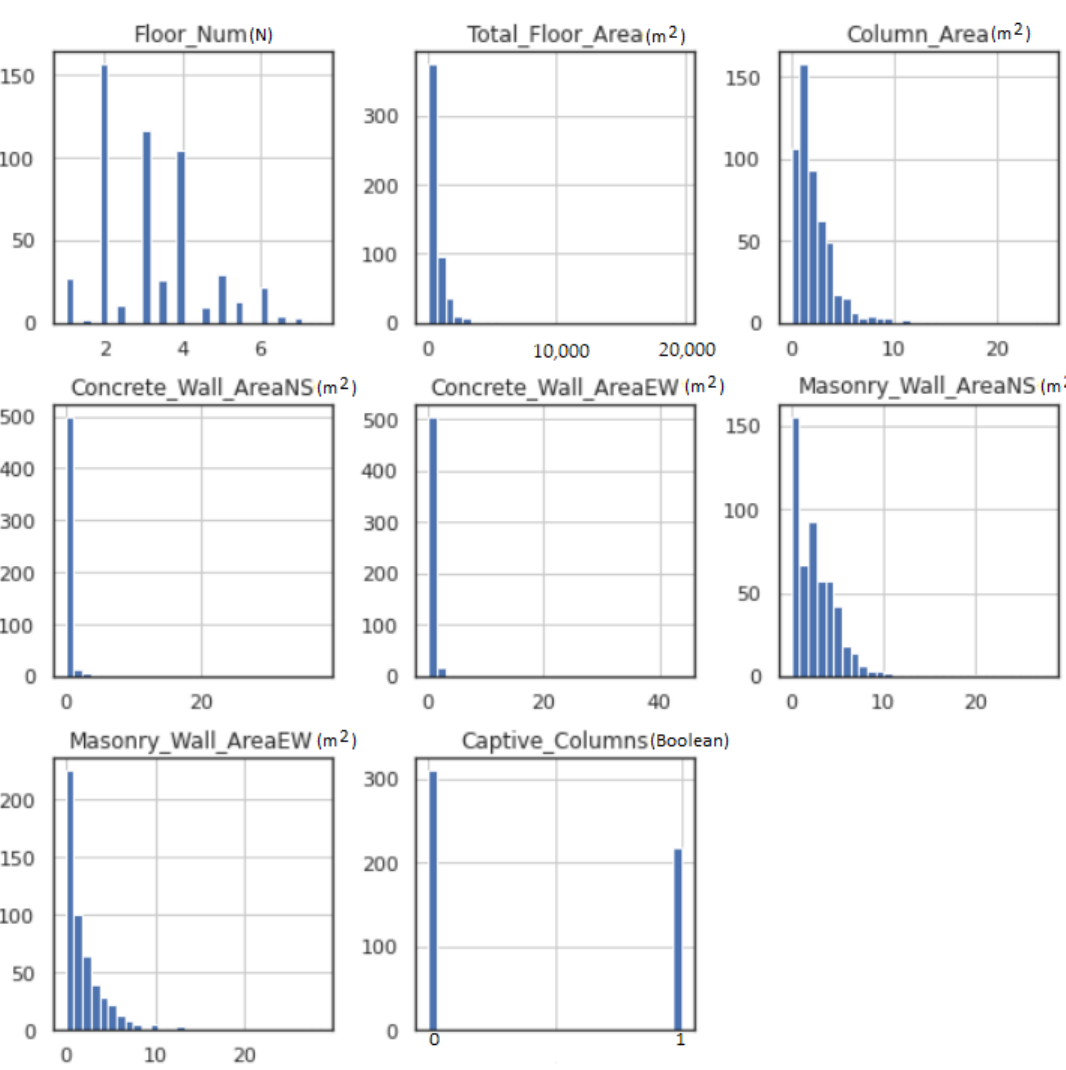
Figure 2. Distribution of data over each input